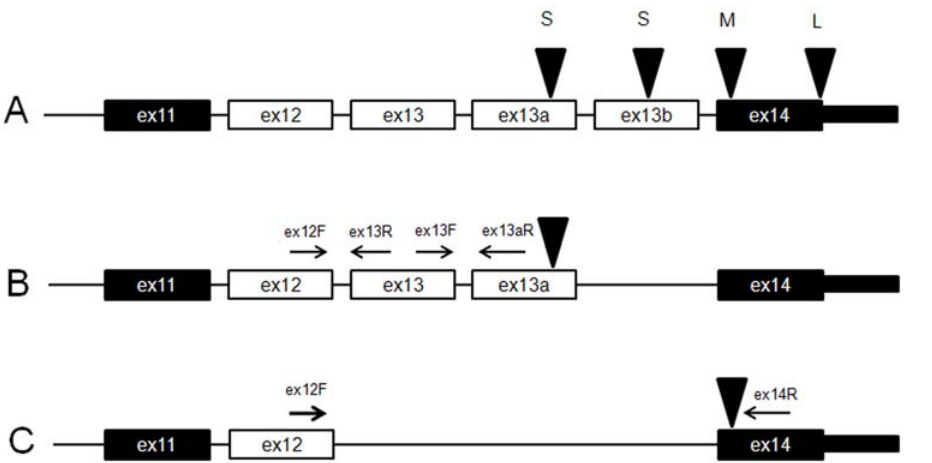
Figure 2. Alternative splicing forms of TCF7L2 with increased expression in subcutaneous compared to omental adipose. A . Constitutive exons 11 and 14 are marked as black rectangles, alternative exons 12, 13, 13a, 13b are marked as white rectangles, black triangles above exons indicate location of alternative stop codons that define protein reading frames: short (S), medium (M) or long (L); B . Alternative splicing form with exons 11-12-13-13a (GenBank FJ010174) has an alternative stop codon within exon 13a and encodes a protein with short reading frame; C . Alternative splicing form with exons 11-12-14 (GenBank FJ010170) has an alternative stop codon in the beginning of exon 14 and encodes a protein with medium reading frame. Positions of expression assays ‘‘ex12-13’’, ‘‘ex13-13a’’ and ‘‘12-14’’ used in this study are indicated above corresponding